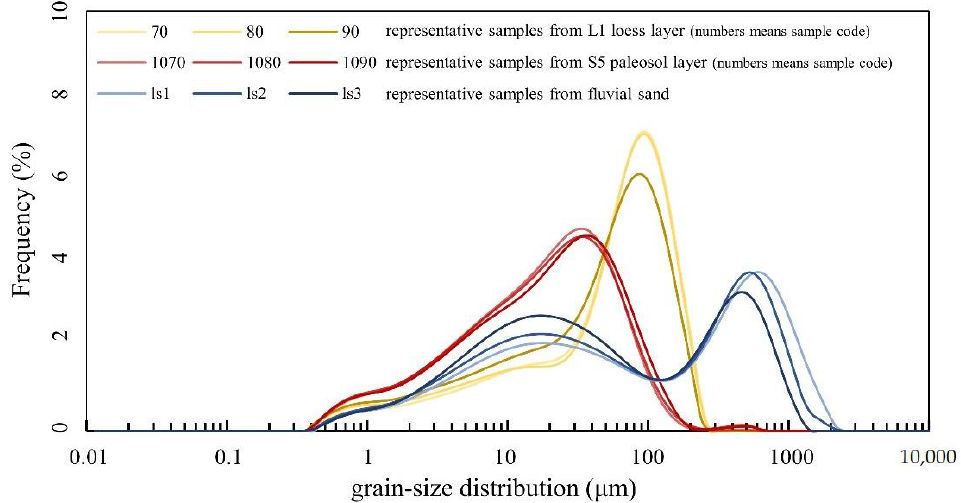
Figure 10. The grain-size distribution of sediments at the NGC site. The brown, red and blue lines represent the grain-size distribution of typical loess (L1), paleosol (S5) and fluvial sand, respectively. Samples coded in numbers represent the depth (cm) of loess overlaying the terrace T8, ls1-ls3 are fluvial sand powder samples from the sand on top of the gravel of terrace T8.